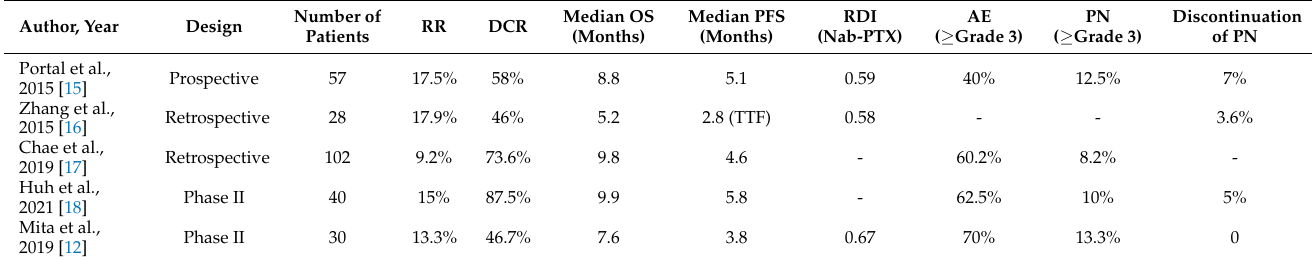
Table 6. Available studies on second-line GnP after the failure of first-line